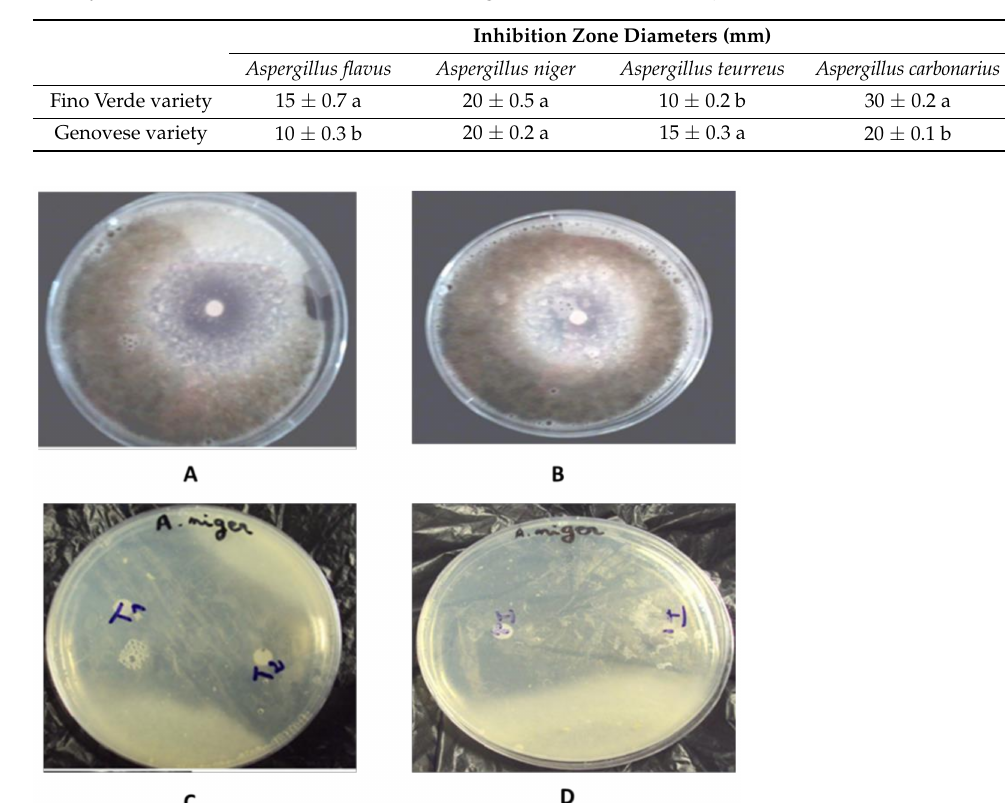
Table 5. Antifungal activity of essential oil of two O. basilicum varieties in flower stage; values are represented by mean ± standard deviation of at least three independent replicates. Within the same variety, different letters on the bars indicate significant differences at p < 0.05.